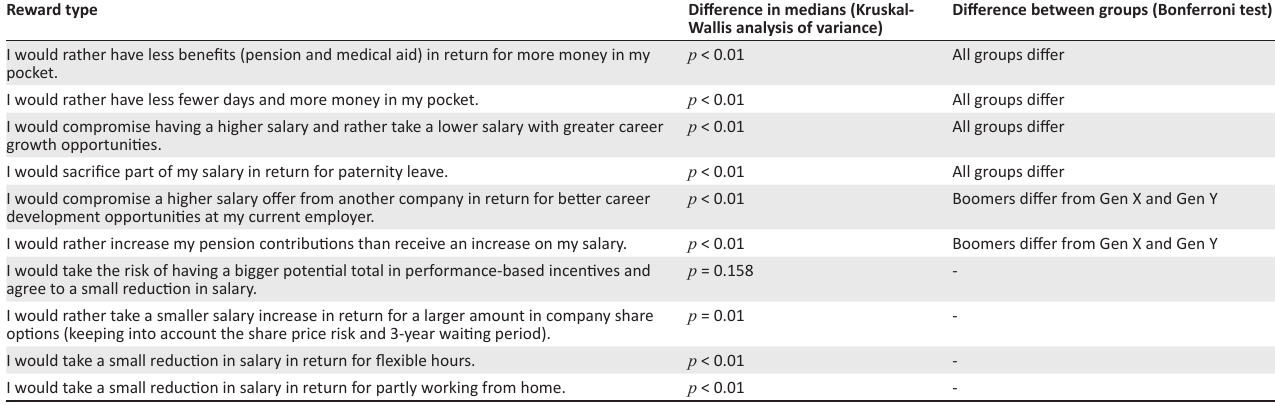
TABLE 7: The preferences of the generations towards the components of the total reward package in the company. Reward